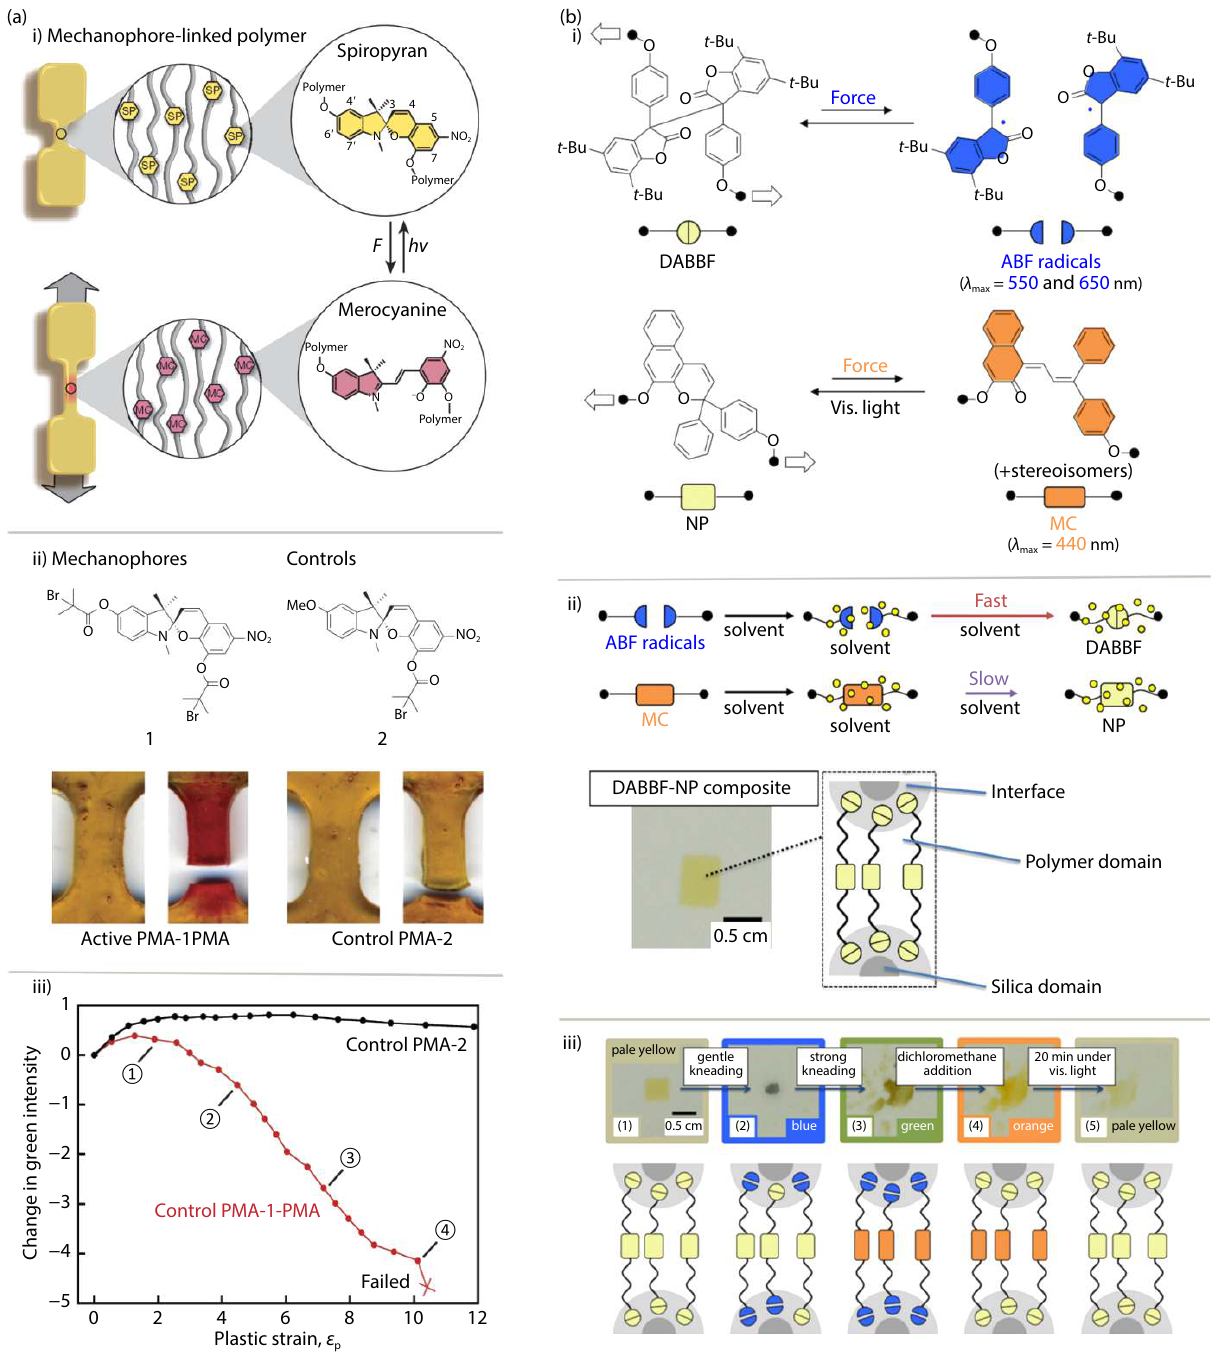
Fig. 9 Force-induced self-reporting materials. ( a ) Spiropyran as a mechanophore. (i) Schematic diagram of a mechanophore-linked PMA “dog bone” specimen and its mechanochromic behaviour. (ii) Distinct effects of tensile loading on the active PMA-1-PMA and monofunctional PMA-2 specimens. (iii) Accumulation of plastic (unrecovered) strain and relative change in green intensity for PMA-1-PMA and PMA-2 samples after each loading cycle in a fatigue test. Reproduced with permission from ref. [52], © 2009 Macmillan Publishers Limited. ( b ) Multicolor mechanochromism of a polymer/silica composite with dual distinct mechanophores. (i) Chemical structures of two mechanophores and their activated states. (ii) Illustration of the two mechanophores' locations in the sample and their reversible mechanochromic behaviours. (iii) Optical photographs and plausible illustrations showing mechanophores’ activation states in the pristine, gently kneaded, strongly kneaded, and dichloromethane−added samples, and the sample left under visible light for 20 min after dichloromethane addition. Reproduced with permission from ref. [165], © 2019 American Chemical